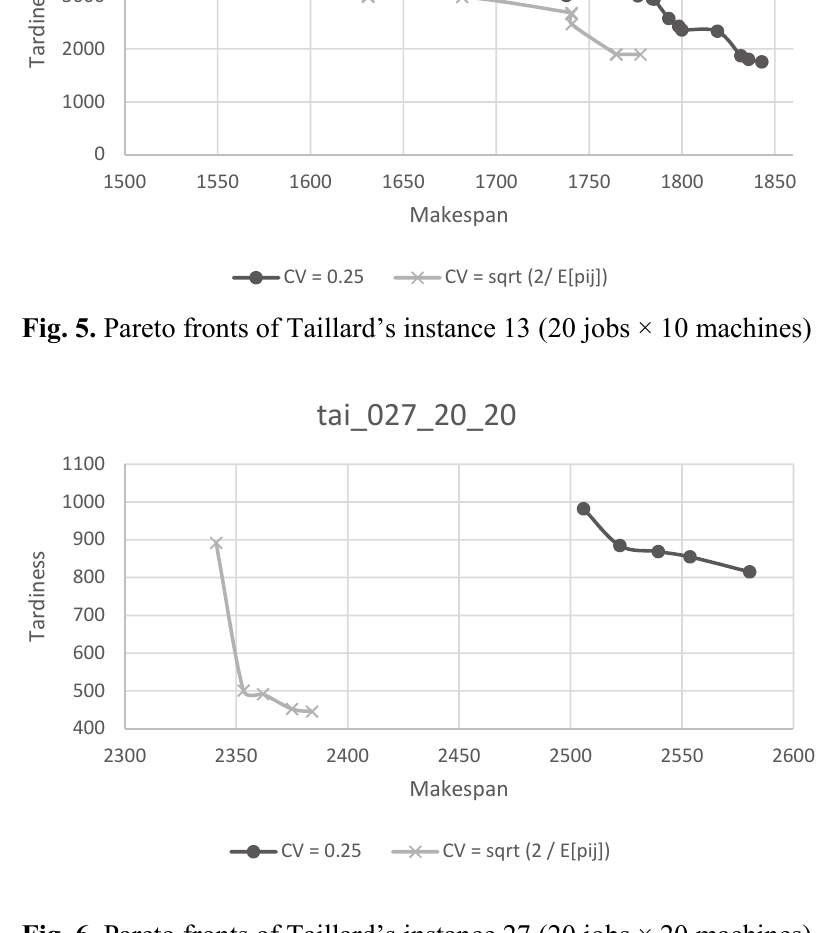
Fig. 6. Pareto fronts of Taillard’s instance 27 (20 jobs × 20 machines)